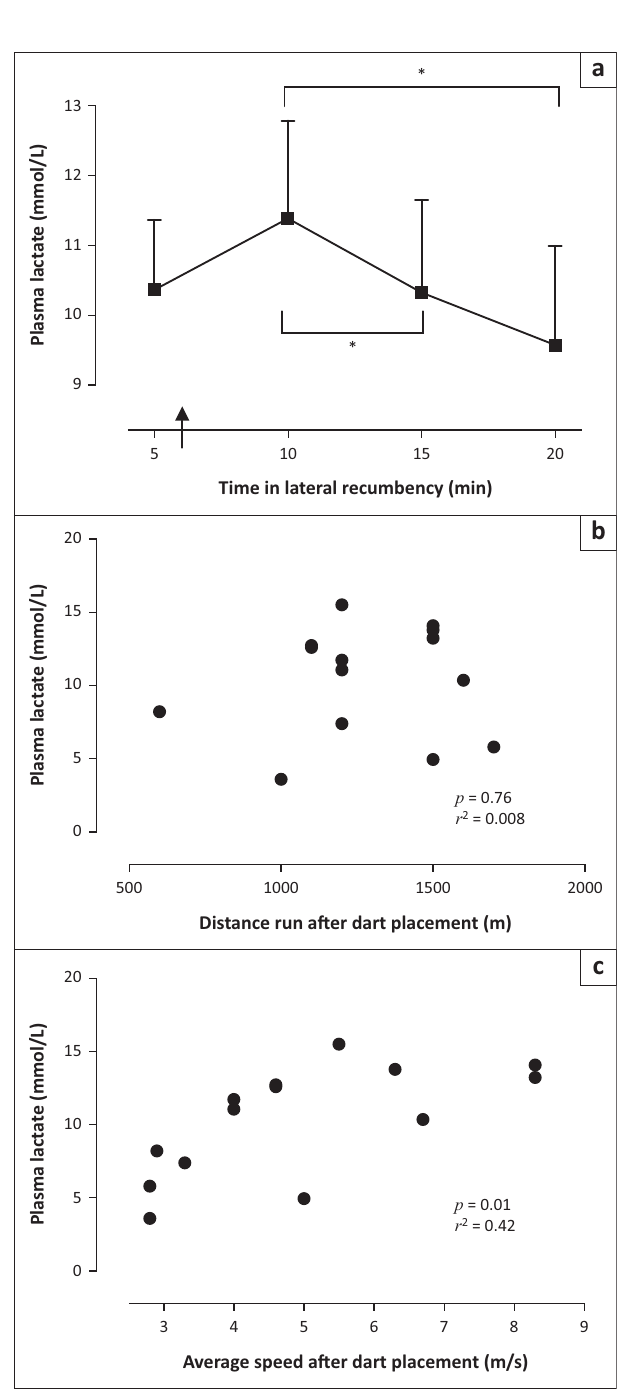
FIGURE 3: (a–c) Plasma